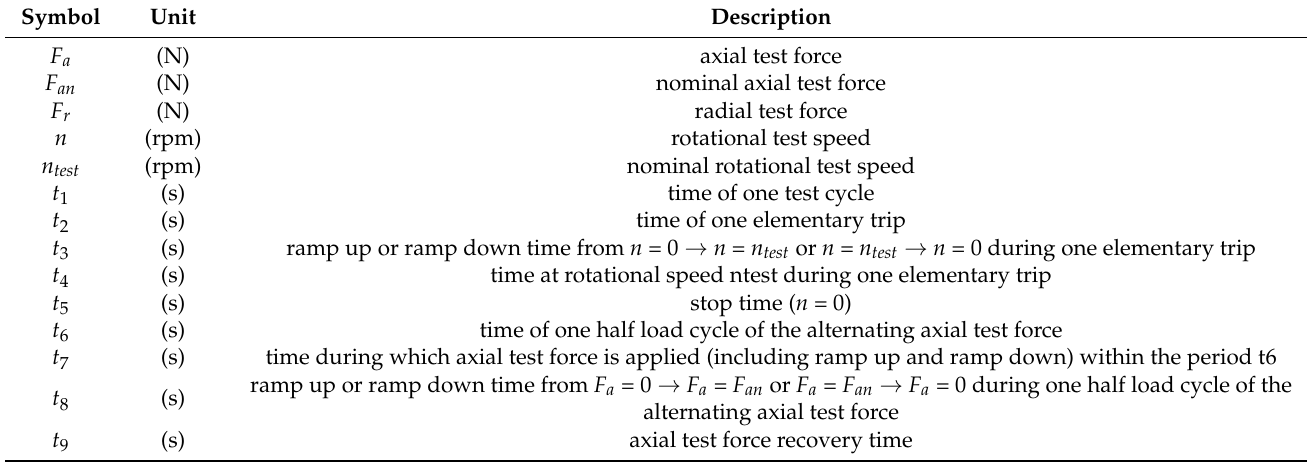
Figure 2. Test cycles. From the top: rotational speed, radial load, and axial load (adapted from EN 12082:2017). Table 2. List of symbols used in Figure 2 (adapted from EN 12082:2017).